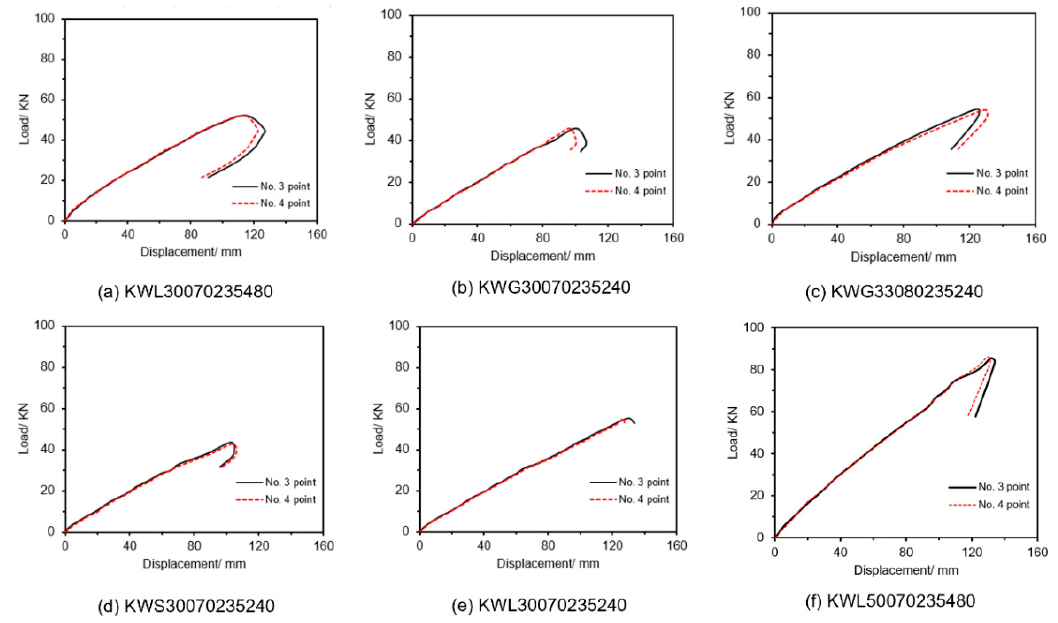
Figure 7. Load-deflection curves for tested NCLT Figure 7. Load ‐ deflection curves for tested NCLT panels. Table 3. Load test results.